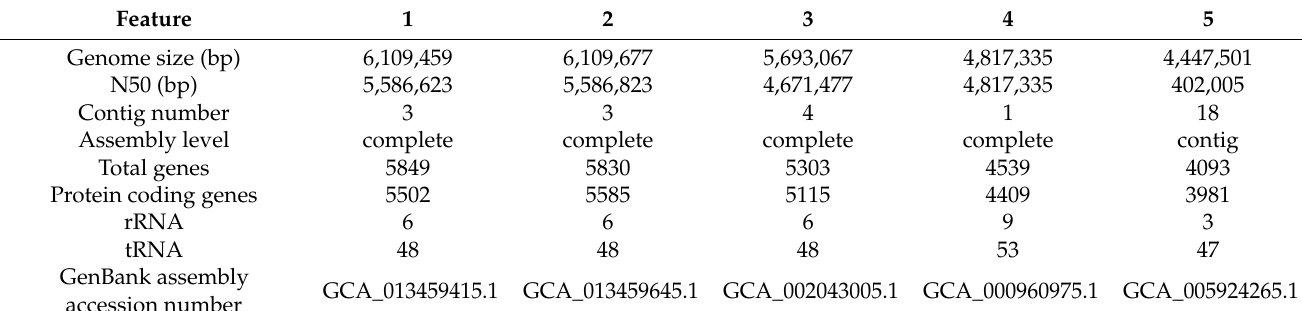
Table 3. Genomic features of strains NC18 T and NC20 with related taxa within the genus Martelella